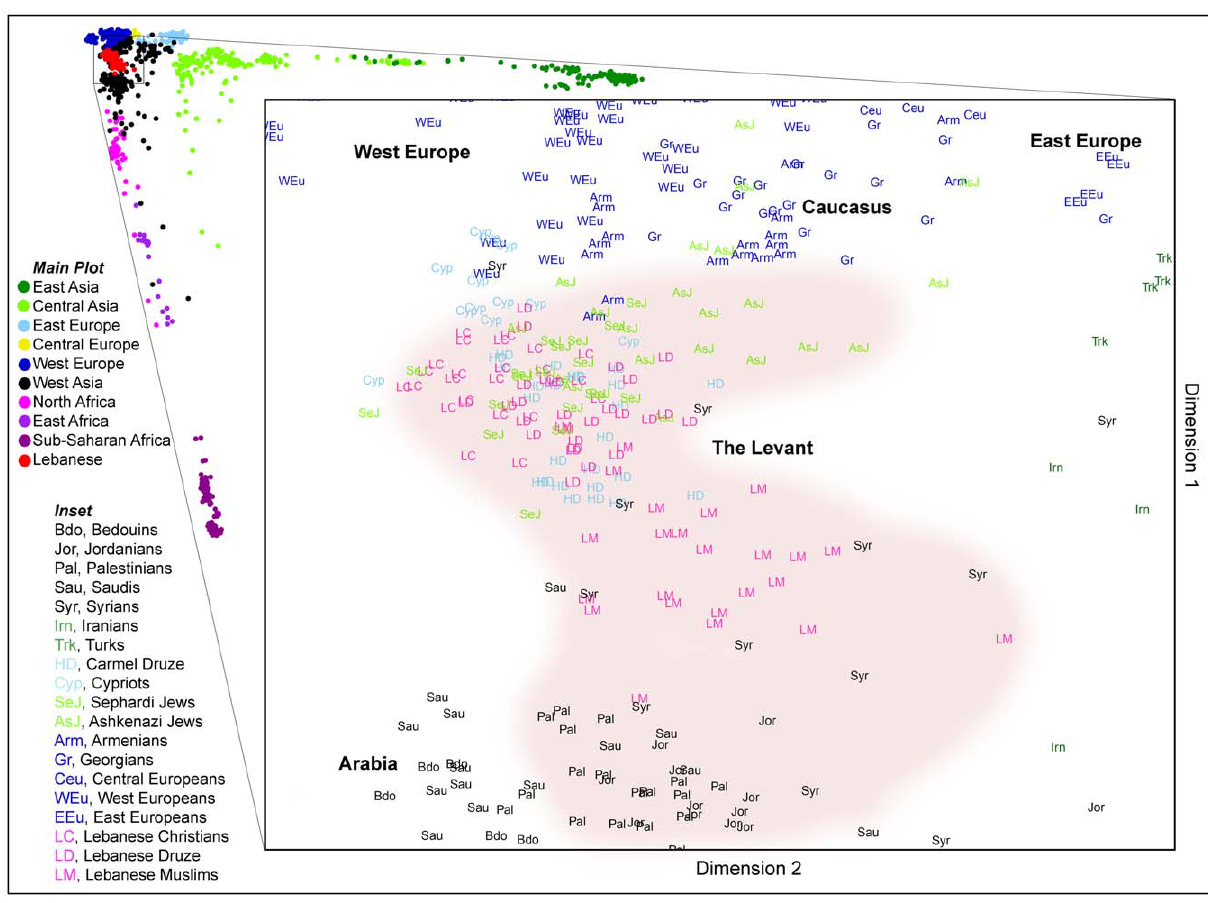
Figure 2. Multidimensional scaling of . 240K SNPs showing the top two dimensions. Main plot shows global diversity using 50 populations. Inset shows Levantine populations in their regional and religion context. The Levant region includes Lebanon, Syria, Jordan, Israel, Palestine, and often Cyprus and historical Armenia. The Levantine core cluster is shaded in pink.